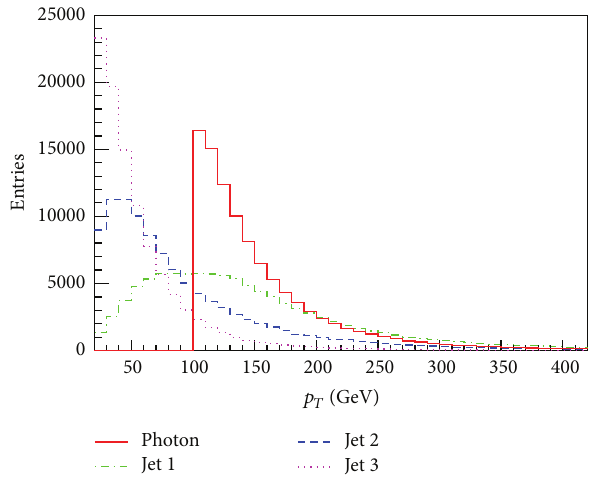
Figure 10: Transverse momentum distributions of leading jet (Jet 1) and other jets (Jet 2 and Jet 3) and photon for background ( 𝑊𝑗𝛾 production).